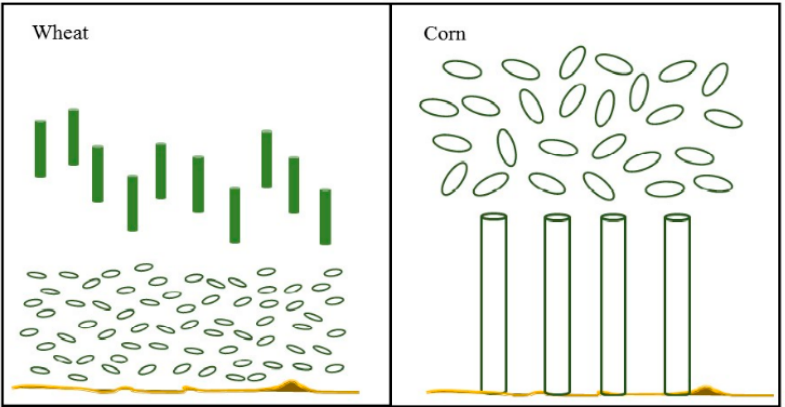
Figure 1. Wheat (left) and corn (right) descriptions in the Tor Vergata model. Figure 1. Wheat ( left ) and corn ( right ) descriptions in the Tor Vergata